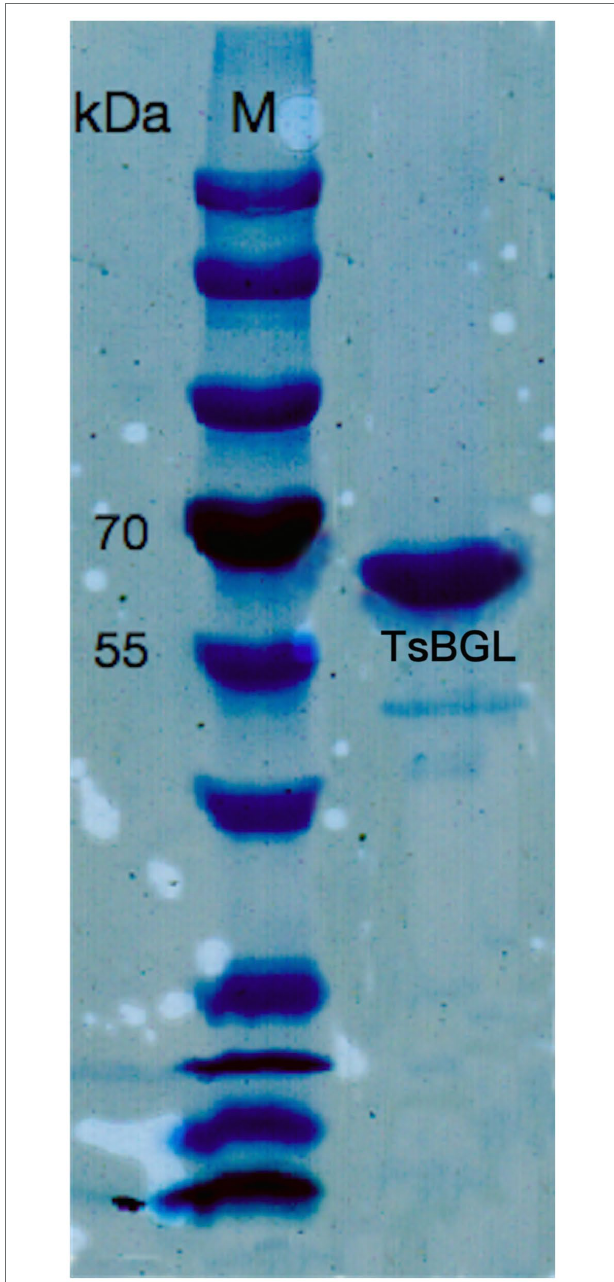
FIGURE 1 | 12% SDS-PAGE of TsBGL, eluted from the Ni column and DEAE column. The left lane was the molecular weight marker (labeled in